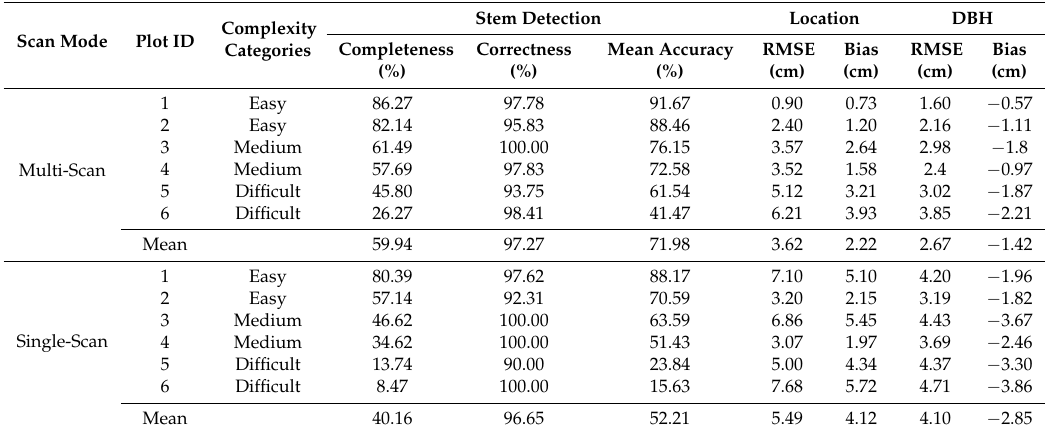
Table 3. The accuracy of stem